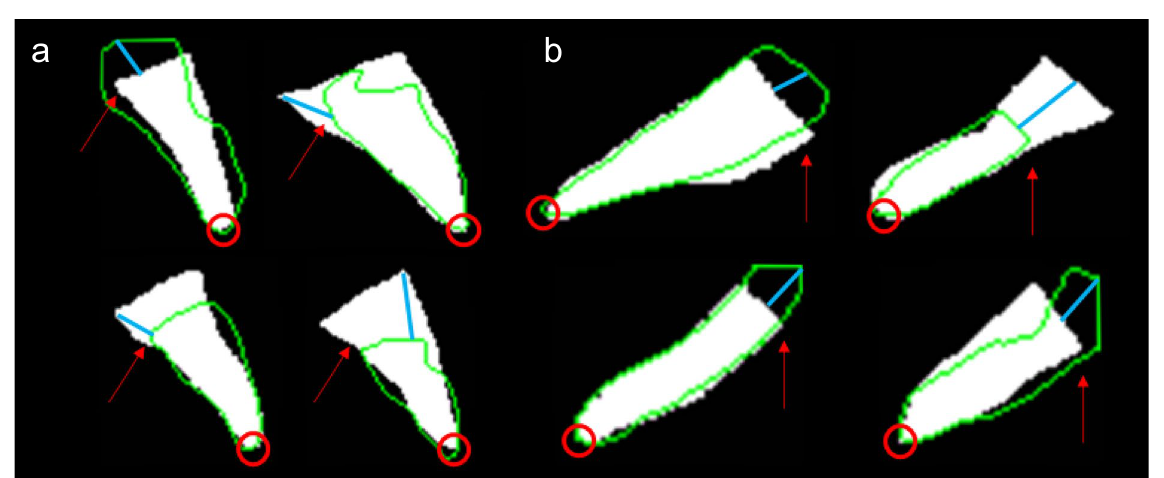
Figure 6. Example of masks that show poor dice coefficient, high HD, and MSD but with high accuracy in regions used for measuring metrics for diagnosing TAOD. Green outlines refer to AU-Net segmentation masks, white masks refer to ground truths. Blue lines refer to a visual depiction of how HD can be calculated. Red arrows refer to posterior ends of cranial bones with inaccurate posterior boundaries but are not used in determining TAOD metrics. Red circles refer to anterior ends that are used for determining TAOD metrics. ( a ) Basion masks. ( b ) Opisthion